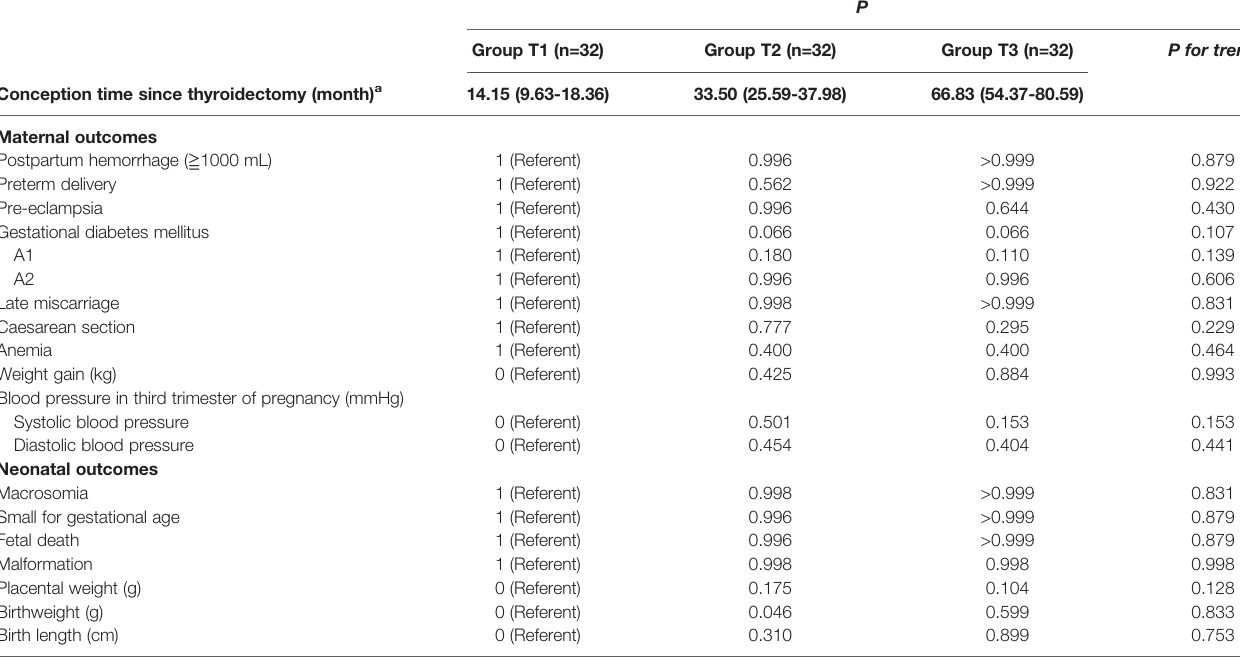
TABLE 6 | Impact of the time interval between conception and